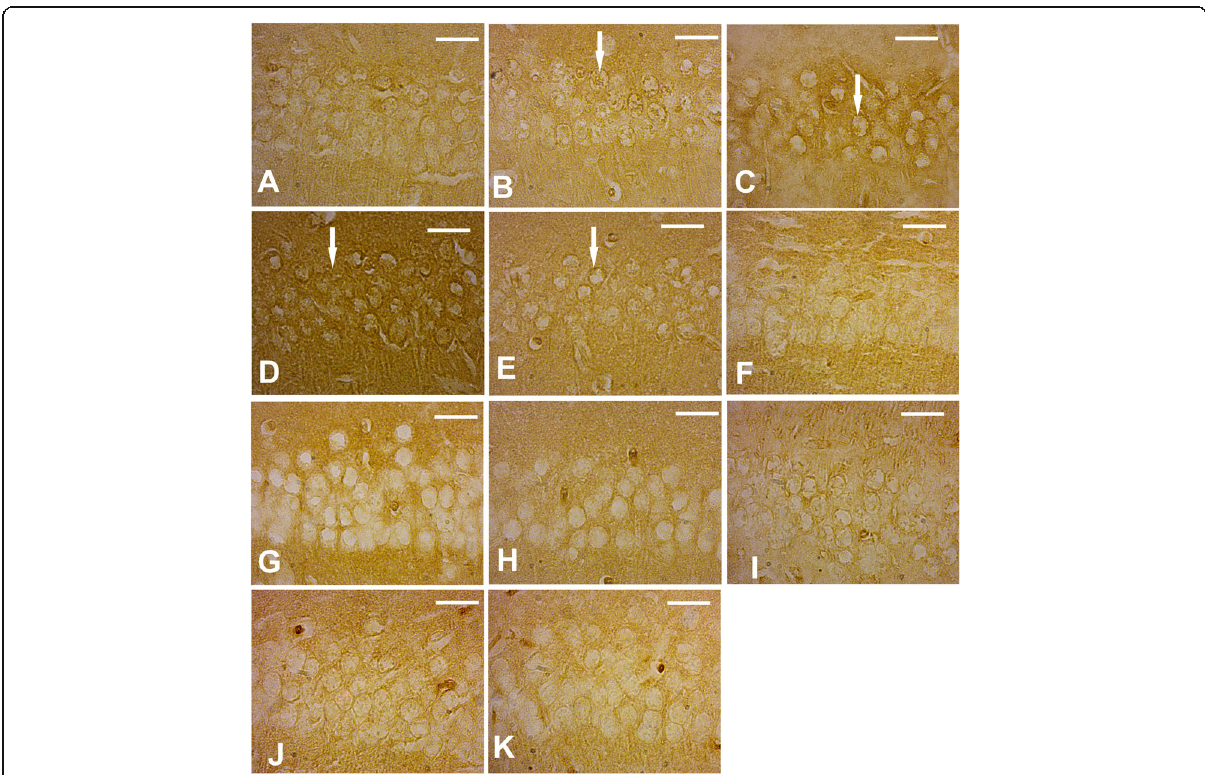
Fig. 5 Photomicrographs of immunohistochemistry of α -synuclein in the CA1 region of the hippocampus of the control group ( a ). The acrylamide-administrated groups showed a gradual increase in the expression from 30 to 45 days of treatment (arrows; b , c ) and denser expression at 60 days (arrows, d ). The chips feeding group at 60 days showed increase of intracellular expression (arrows, e ). The BV- and BPF-treated groups showed nearly the same expression of the control ( f , g ). The acrylamide-administrated groups treated with either BV ( h ) or BPF ( i ) showed normal expression of α -synuclein similar to the control. The chips feeding groups treated with either BV ( j ) or BPF ( k ) showed the normal distribution of staining similar to the control. Immunostaining of α -synuclein; scale bar 5 μ